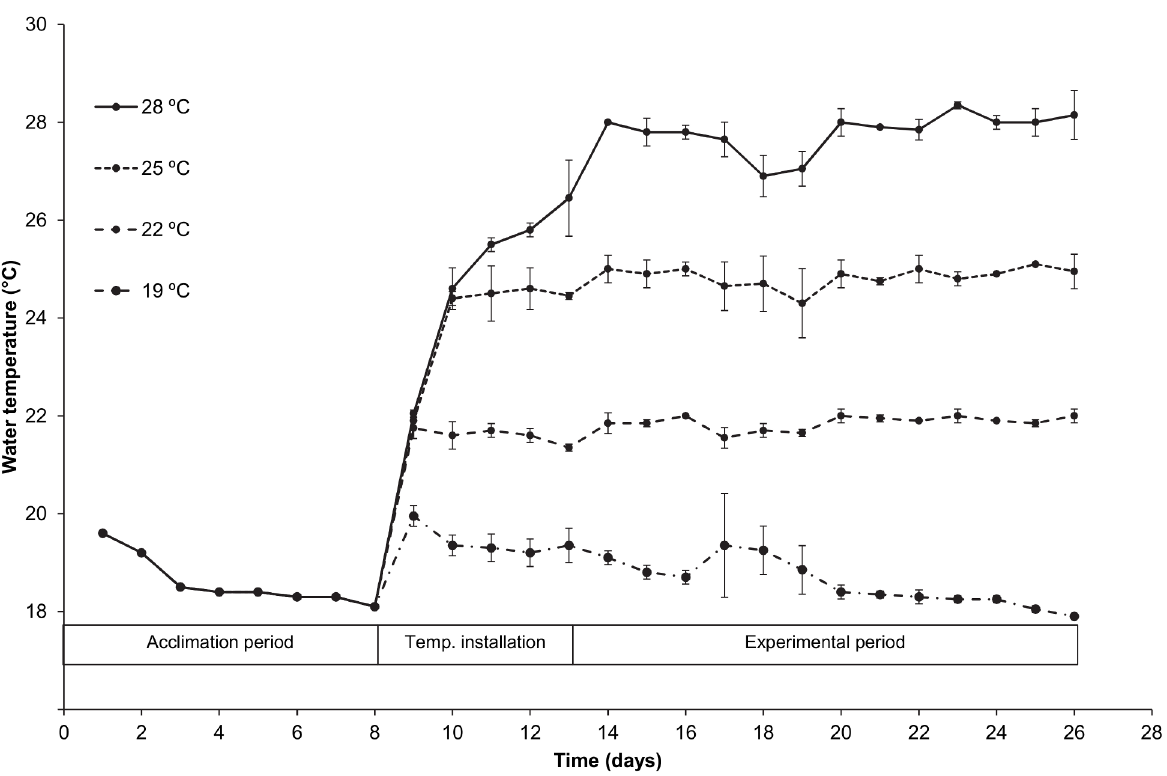
Figure 3. Water temperatures during the growth experiment. For each temperature treatment the mean (SD, n=2) water temperature during the acclimation, installation of temperatures and the experiment is presented. Overall mean temperature per treatment during the experiment (n=26) differed significantly among all treatments (ANOVA, p , 0.0001).